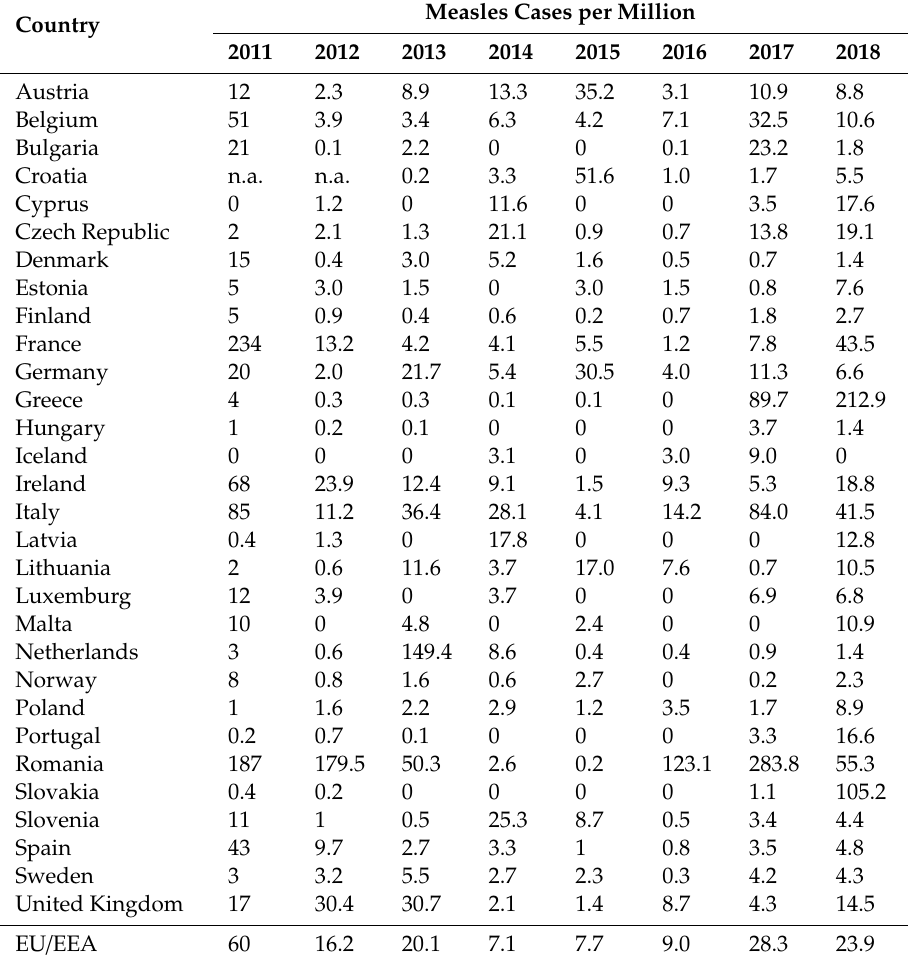
Table 1. New measles cases registered per million per country 2011–2018 (ECDC reports).